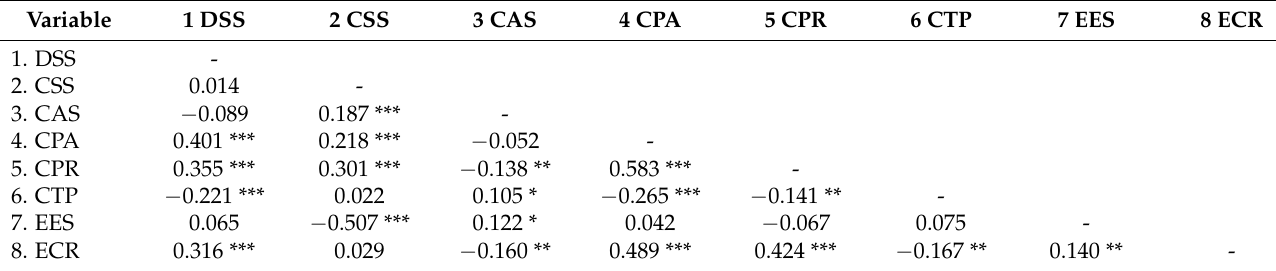
Table 3. Pearson’s Correlations.